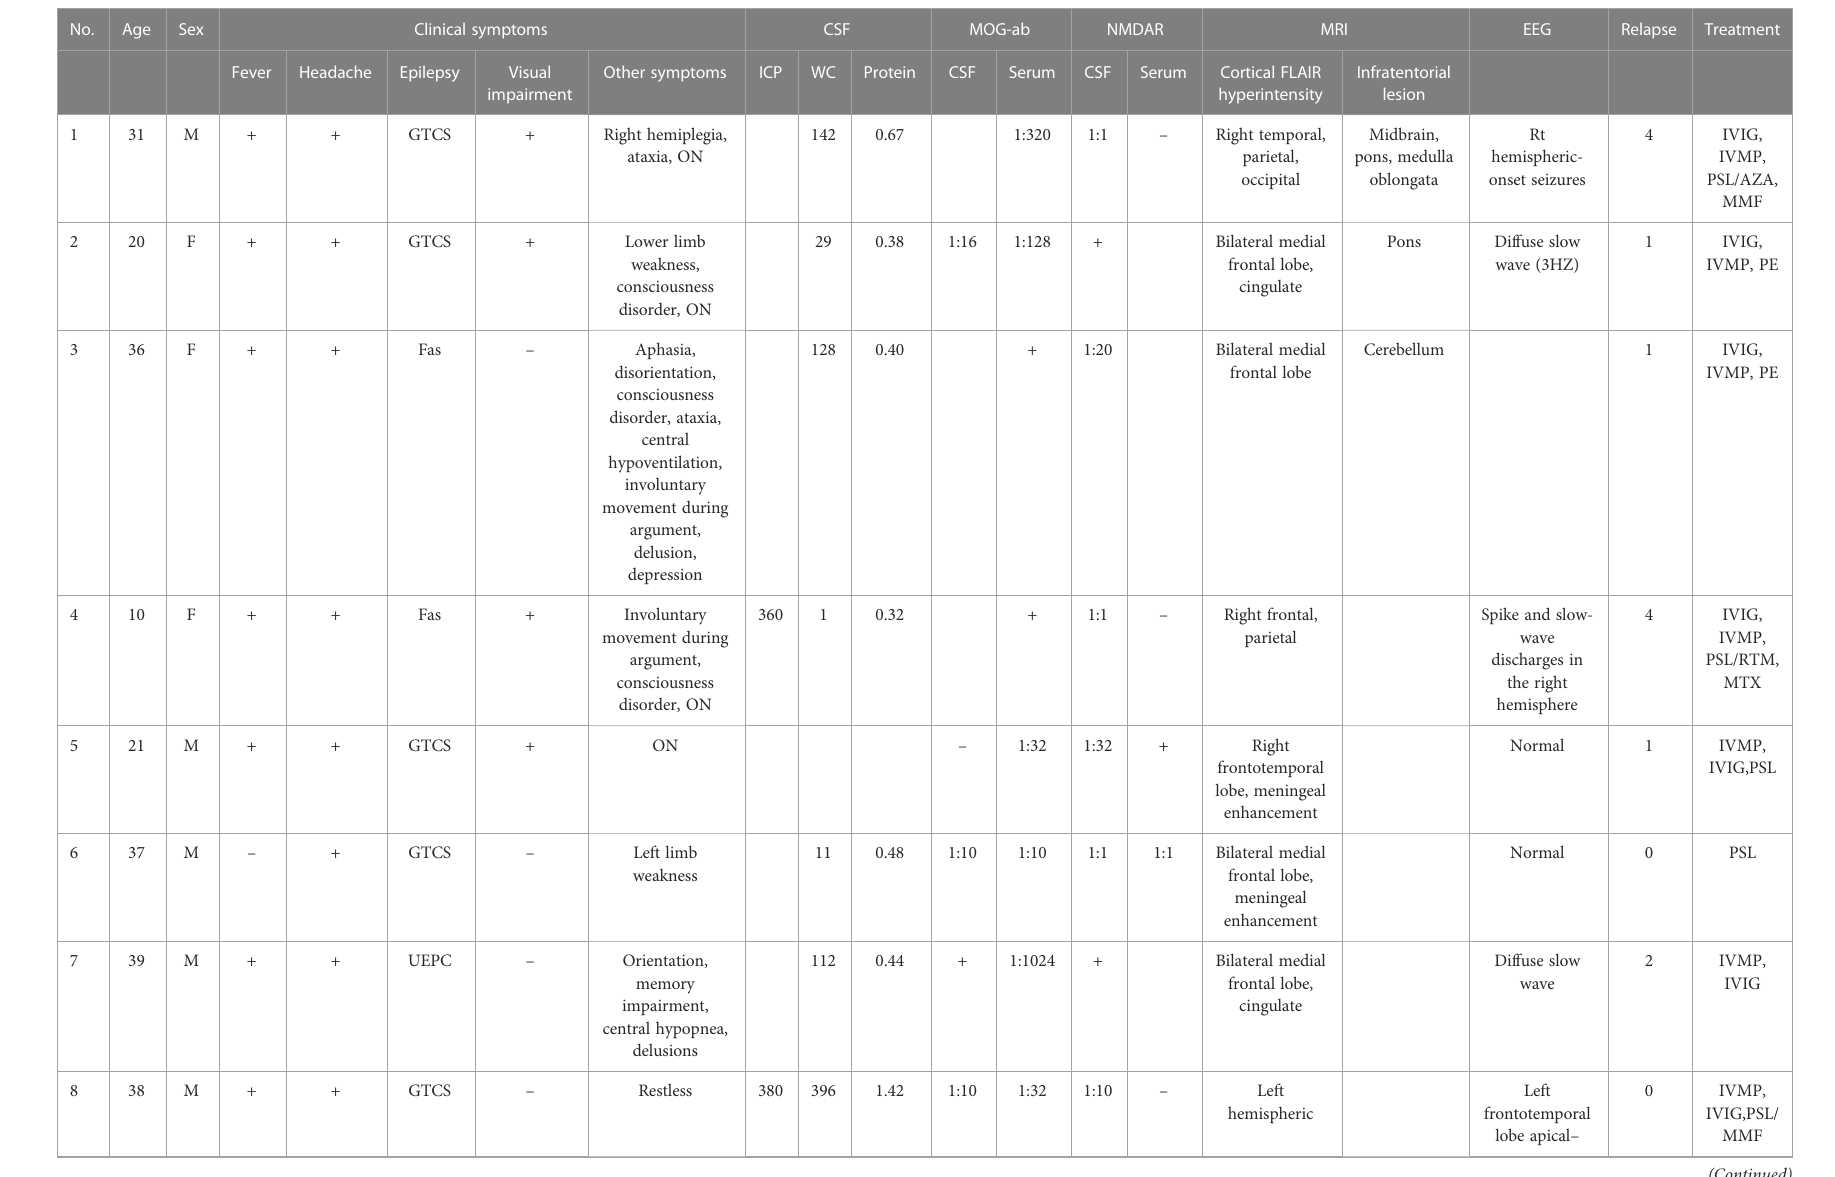
TABLE 1 Summary of cases included in this